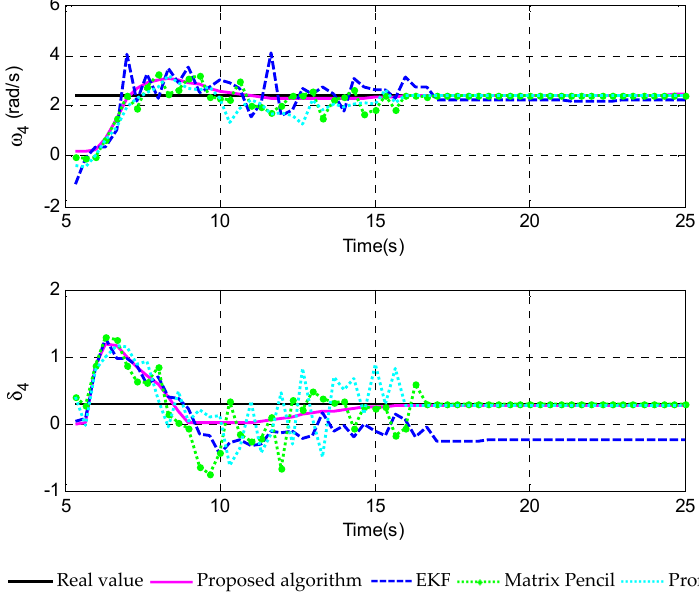
ω δ by using different methods. , 4